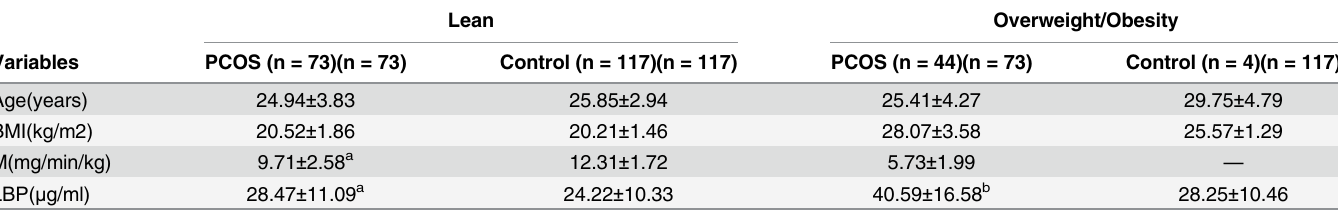
Table 2. Subgroup analysis.